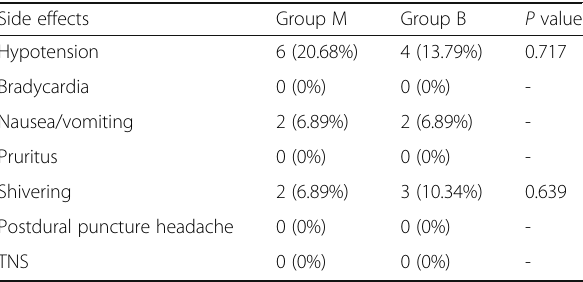
Table 7 The incidence of perioperative adverse events in both study